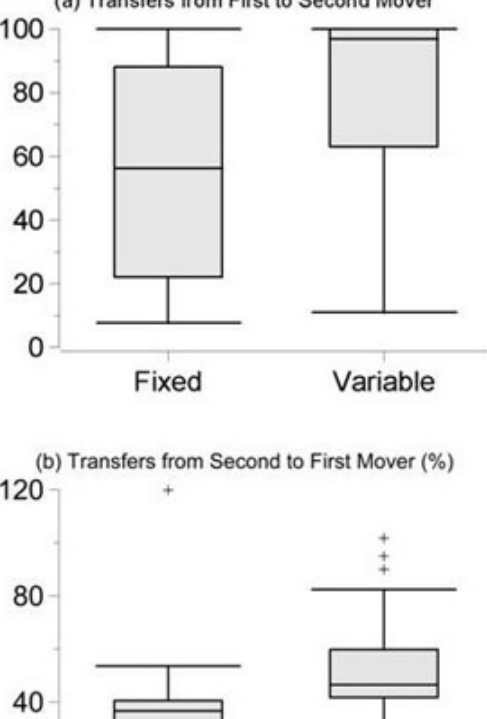
Fig. 1. Transfers within ‘fixed’ and ‘variable’ multiplier treatments, from (a) first to second mover, and (b) second to first mover as a percentage of transfers received. Transfers are per participant, averaged across all rounds. Data shown as box-whisker plots with median, 25, and 75 percentile ranges and outliers, and with the horizontal bars showing minimum and maximum excluding